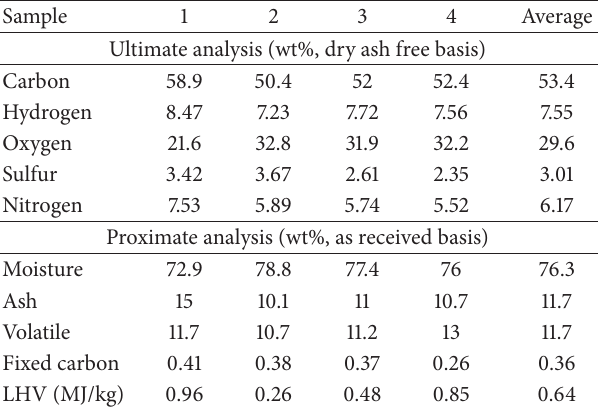
Table 2: Properties of wet sewage sludge.